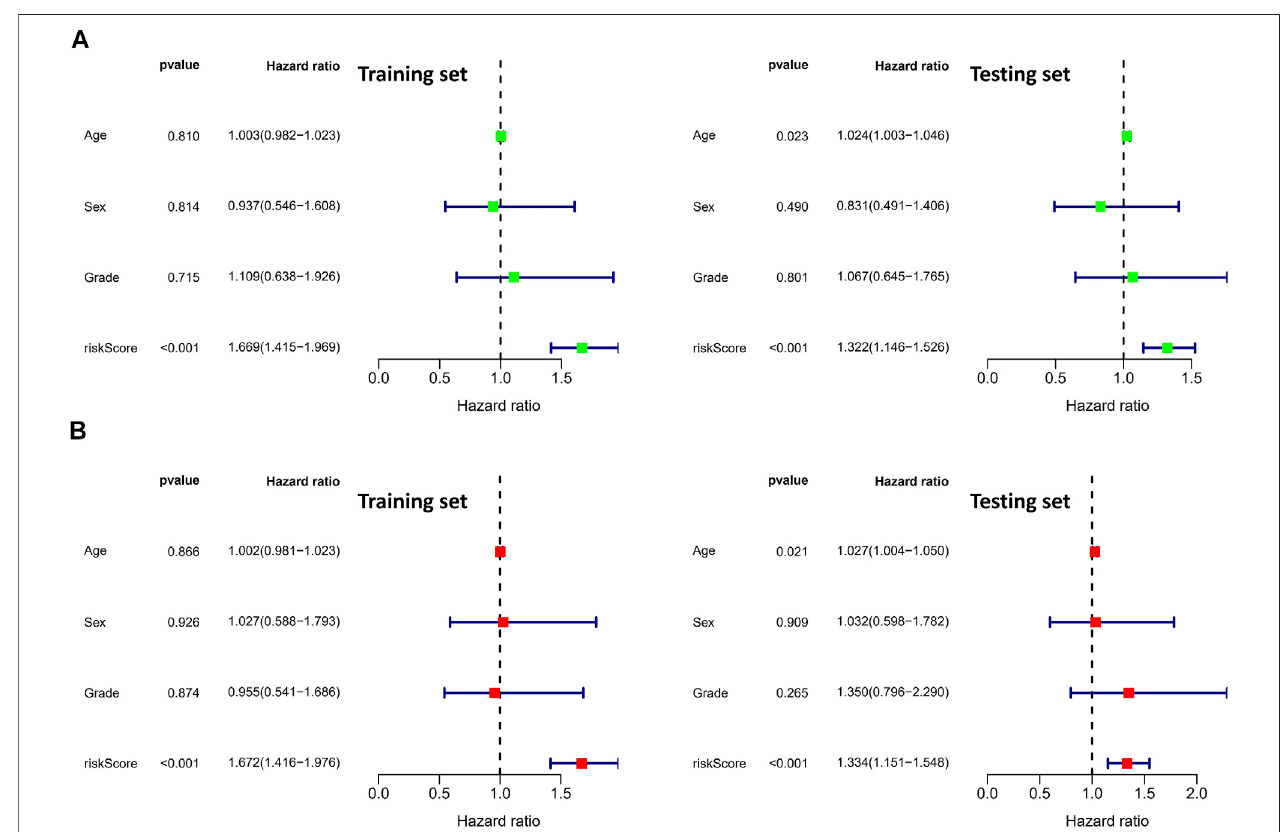
FIGURE 3 | Identi fi cation of independent prognostic factors. (A) Univariate Cox analysis in clinical features and risk score (the left fi gure is the training set and the right fi gure is the testing set). (B) Multivariate Cox analysis in clinical features and risk score (the left fi gure is the training set and the right fi gure is the testing set).